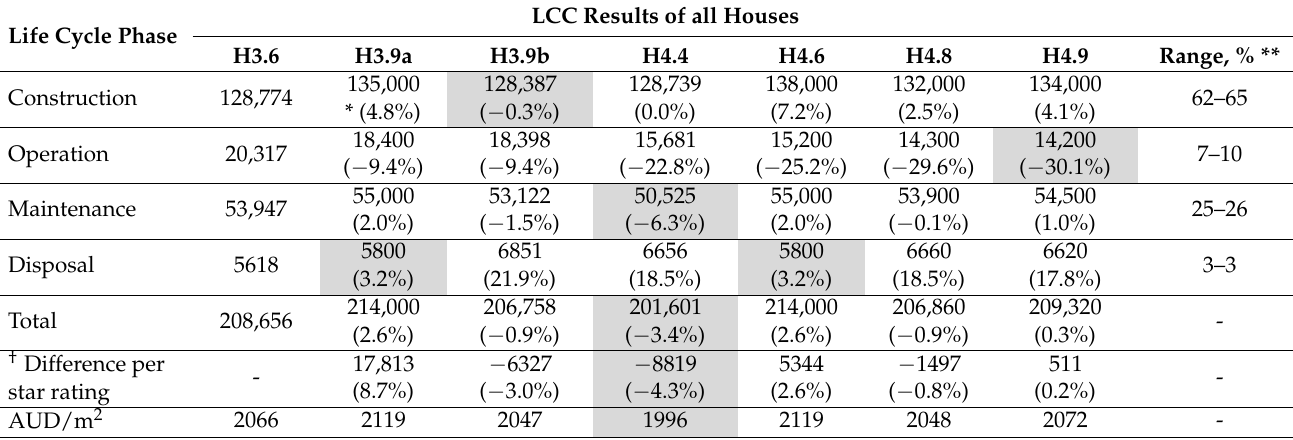
Table 11. Life cycle cost (AUD) for all house